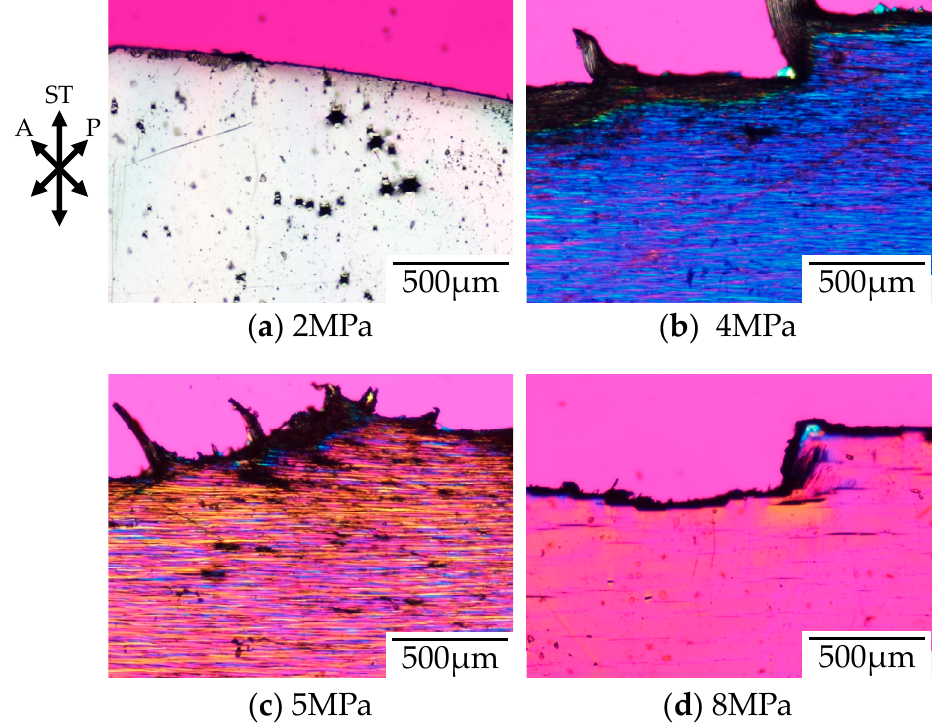
Figure 5. Polarized optical micrographs of stretched-and-fractured OD-PC obtained by stretching at 30 °C under CO 2 of various pressures.